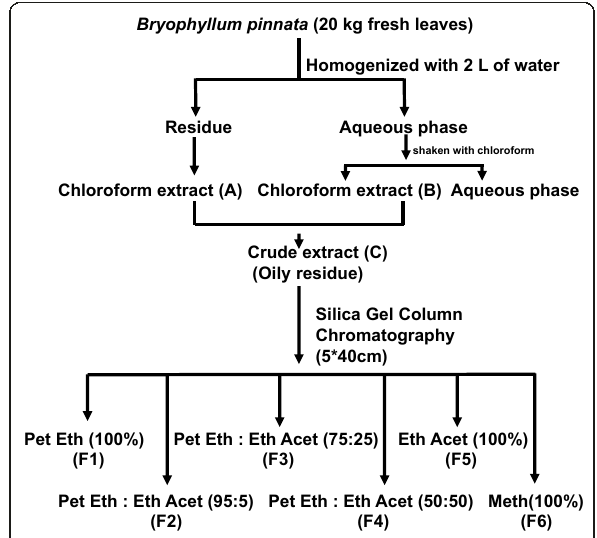
Figure 1 Flow chart of extraction and column chromatographic separation of Bryophyllum pinnata leaves . 20 kg fresh leaves of B. pinnata were crushed with water and filtered. Residue was dried and extracted with chloroform and fractionated with gradient of petroleum ether and ethyl acetated followed by washing with methanol. Fractions were designated as F1 to F6 as indicated in the figure. Pet Eth, Petroleum Ether; Eth Acet, Ethyl Acetate; Meth,